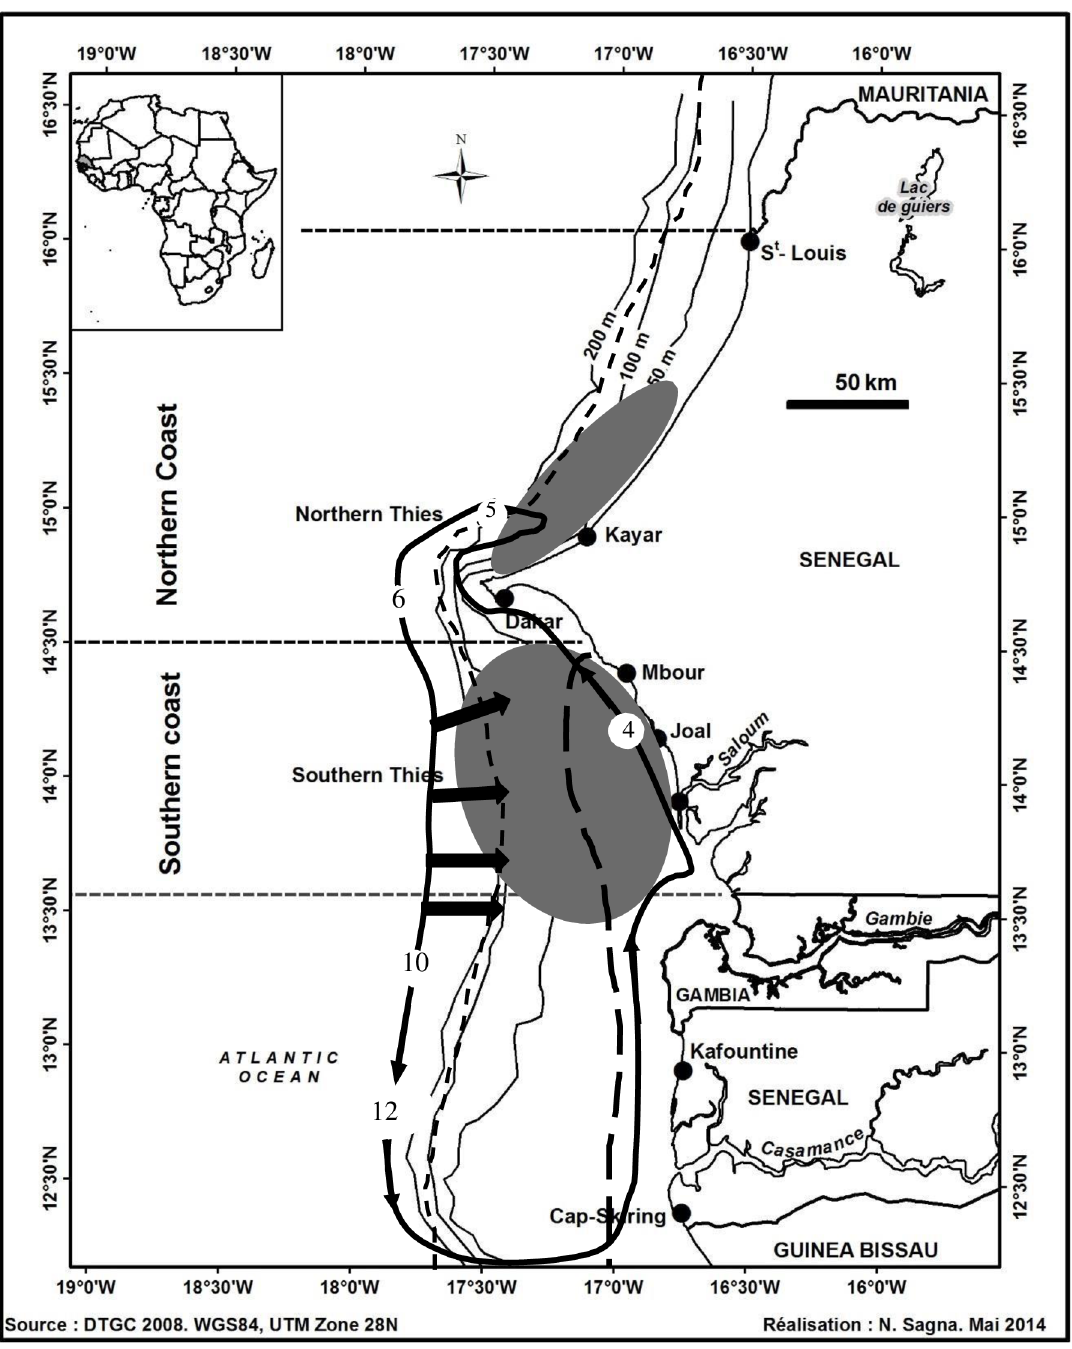
Fig 1. Map of the study area, fishing areas (dark ellipses) covered by sampling sites (Kayar, Mbour, and Joal) and overlay of spatial distribution and migration pattern of Sardinella maderensis (adapted from [13]). “ Grande Côte ” is the northern part (Dakar to Saint-Louis including Kayar) with a narrow continental shelf and “ Petite Côte ” is the southern part (Dakar to Sine-Saloum) with a wider continental shelf. Casamance is further south between Gambia and Guinea-Bissau. The nursery areas are delimited by a long dashed line (starting at the coast) and the spawning areas are delimited by a continuous bold line with arrows and numbers (months).